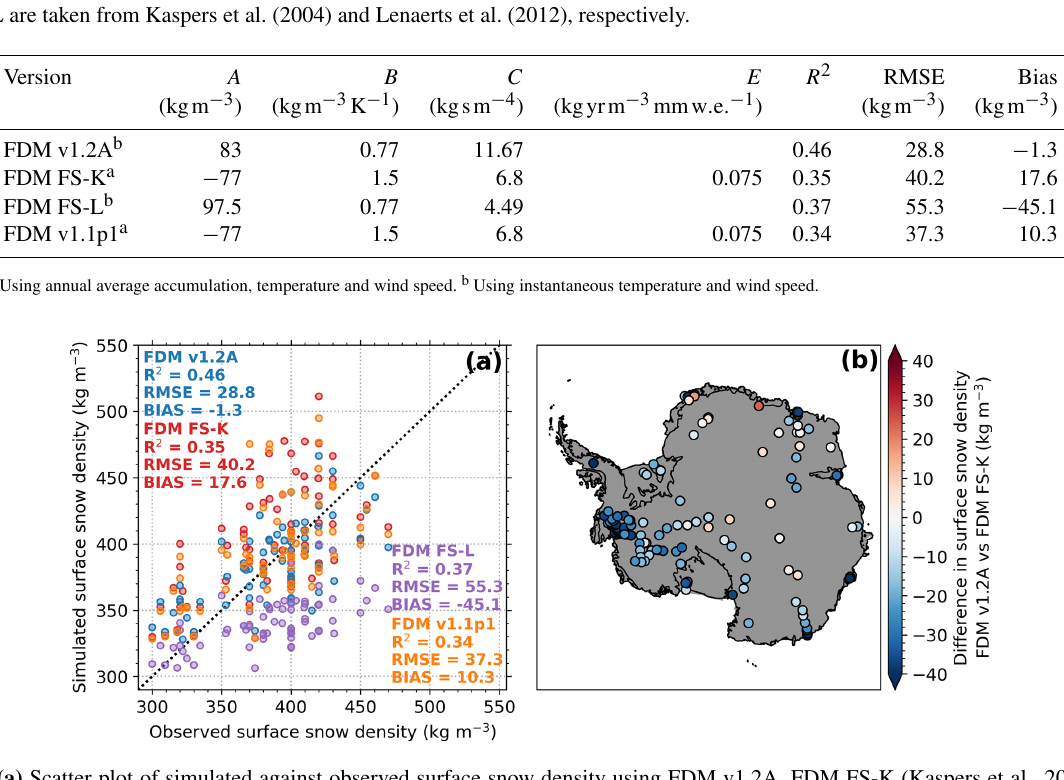
Figure 2. (a) Scatter plot of simulated against observed surface snow density using FDM v1.2A, FDM FS-K (Kaspers et al., 2004), FDM FS-L (Lenaerts et al., 2012) and FDM v1.1p1. (b) Map of average difference between the simulated surface snow densities of FDM v1.2A and FDM FS-K for the locations with